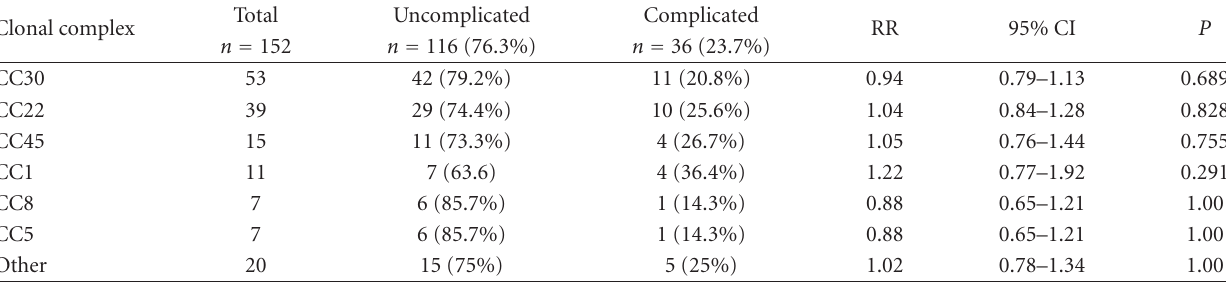
Table 4: Lineages of 152 S. aureus isolates from episodes of uncomplicated and complicated bacteraemia.